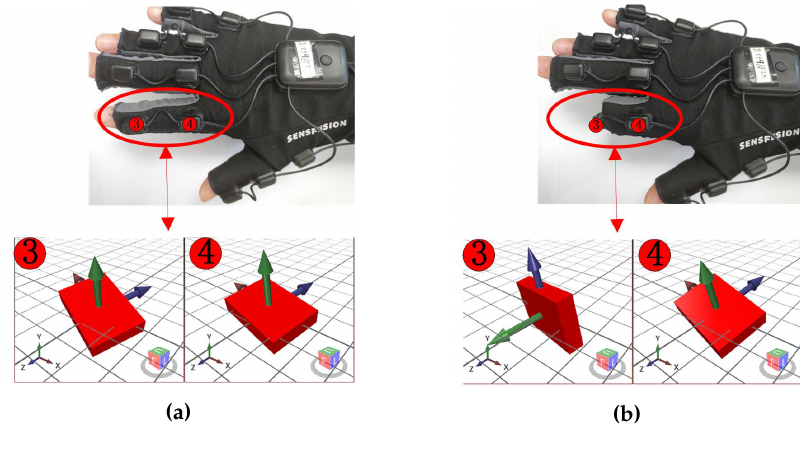
Figure 6. The example of how the IMUs attached on the index finger measure the rotation. ( a ) The initial poses of the 3rd and 4th IMU are equal Q 3 = Q 4 , when Index finger is stretching. ( b ) The relative ∗ Q − 1 pose Q 3,4 = Q ∗ of the 3rd and 4th IMU, when the index finger is blend. Q 3,4 can represent the 3 4 3rd IMU rotate 90 degrade counterclockwise around axis x related to the 4th